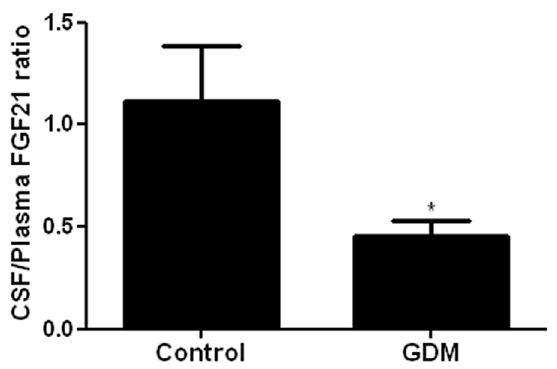
Figure 1. CSF/Plasma FGF21 ratio was significantly lower in women with GDM ( n= 14) compared to control subjects